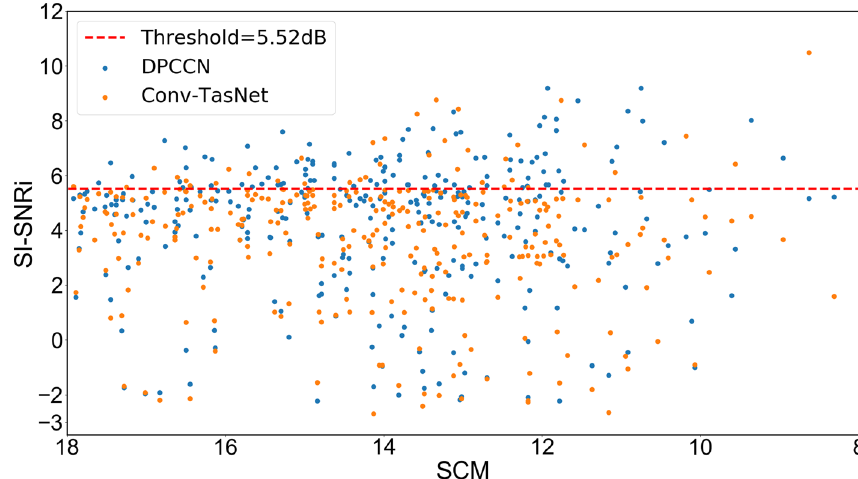
Fig. 5 SI-SNRi (dB) of DPCCN and Conv-TasNet separation results of the 310 “bad cases” varies with the separation consistency